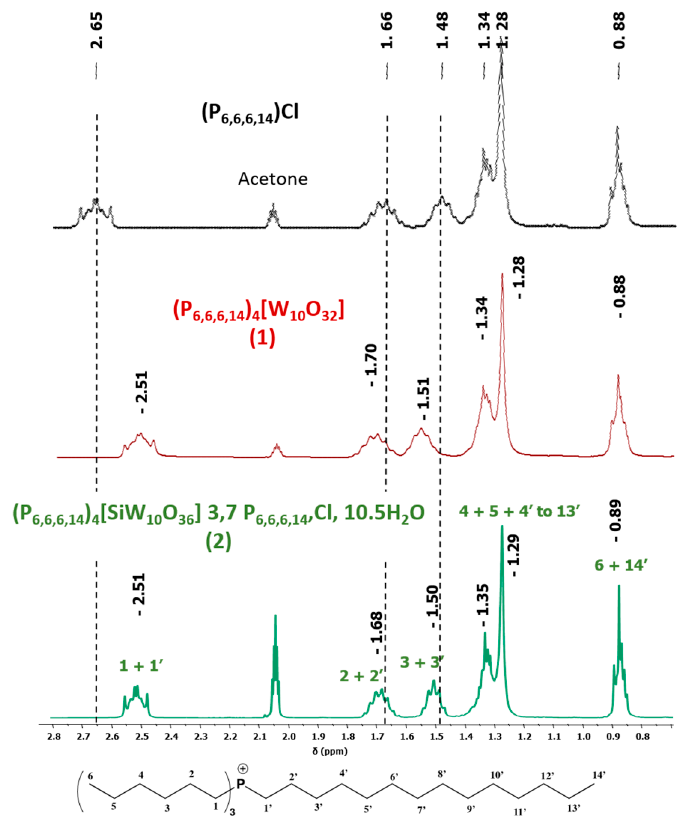
Figure 3. 1 H NMR spectra comparing (P 6,6,6,14 ) 4 [W 10 O 32 ] ( 1 ), (P 6,6,6,14 ) 8 [SiW 10 O 36 ].3.7P 6,6,6,14 Cl 10.5H 2 O ( 2 ) and (P 6,6,6,14 )Cl in acetone- d 6